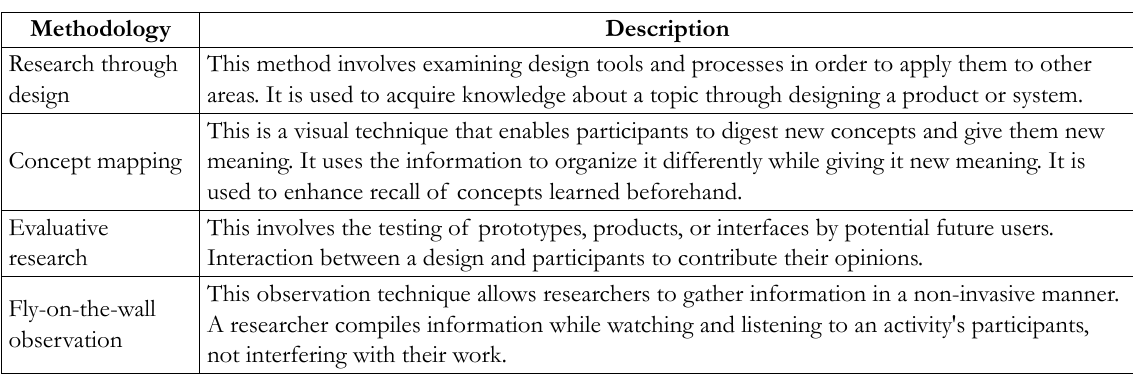
Table 1. Description of the design methodologies used in the